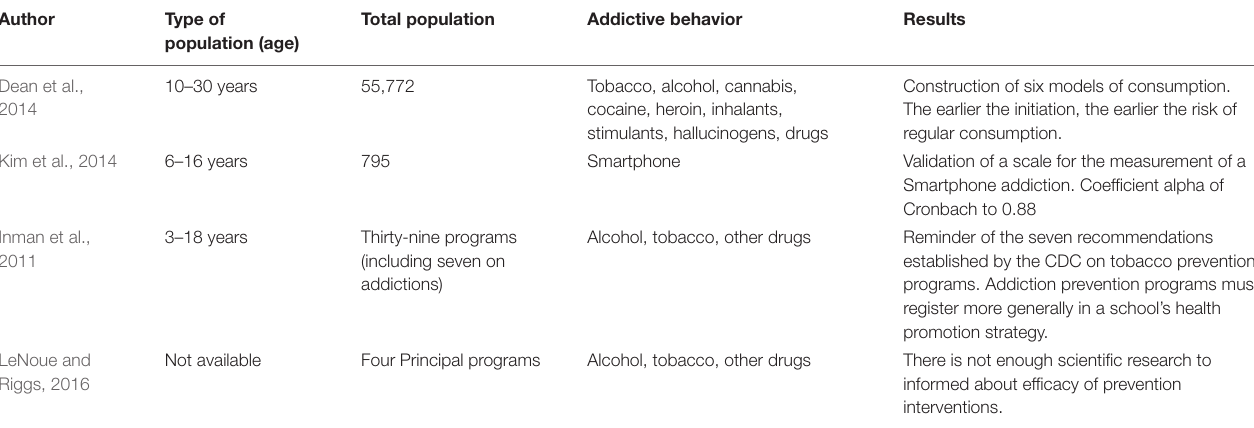
TABLE 5 | Summary of articles on recommendations of CDC, validation of scale on smartphone addiction, and model of